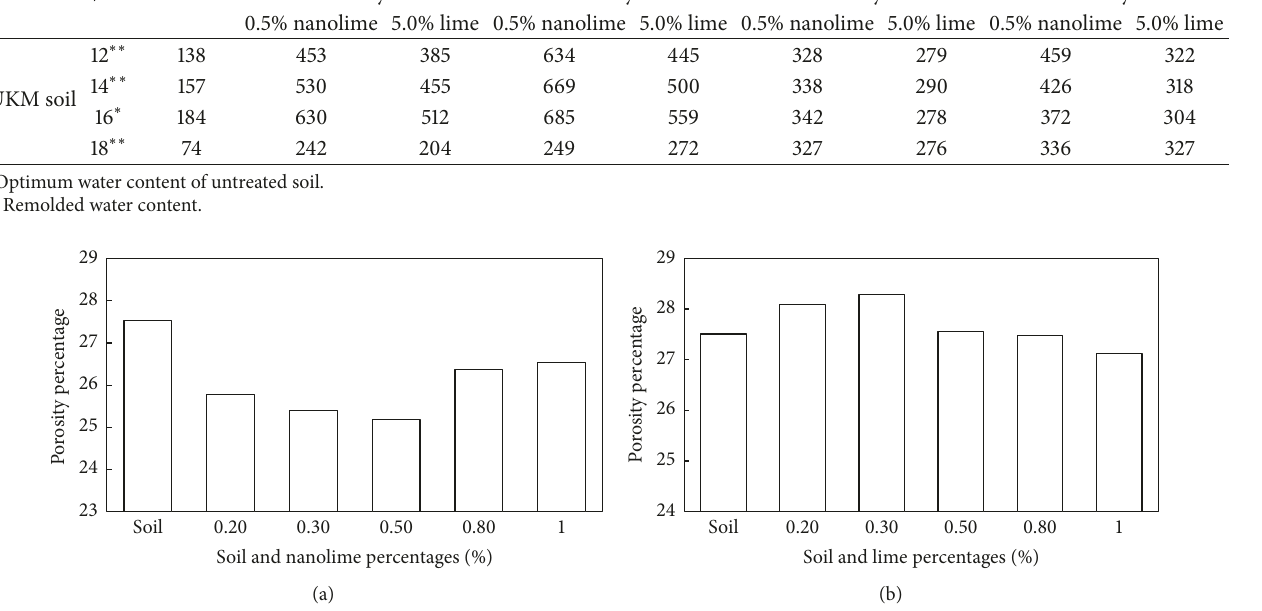
Figure 7: (a) Porosity percentage of soil and soil-nanolime mixtures. (b) Porosity percentage of soil and soil-lime mixtures.